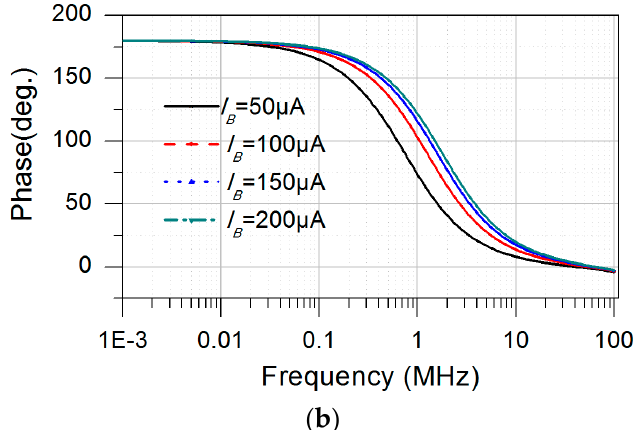
Figure 6. Frequency responses of AP filter at different bias current for ( a ) gain and ( b ) phase.